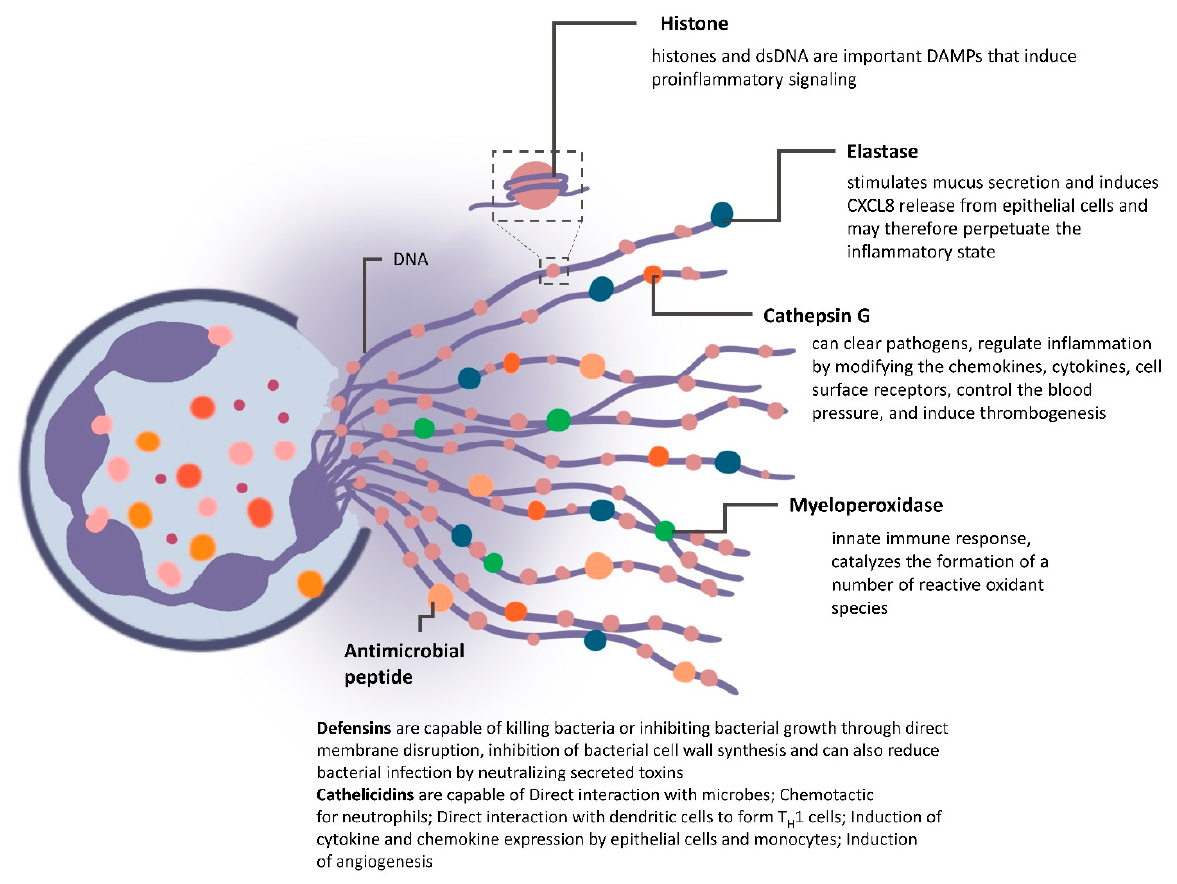
Figure 3. Structure of neutrophil extracellular traps: upon receiving the appropriate stimuli, neutrophils release extracellular DNA traps which are overall composed of histone-decorated DNA strands and proteases, including elastase and cathepsin G.